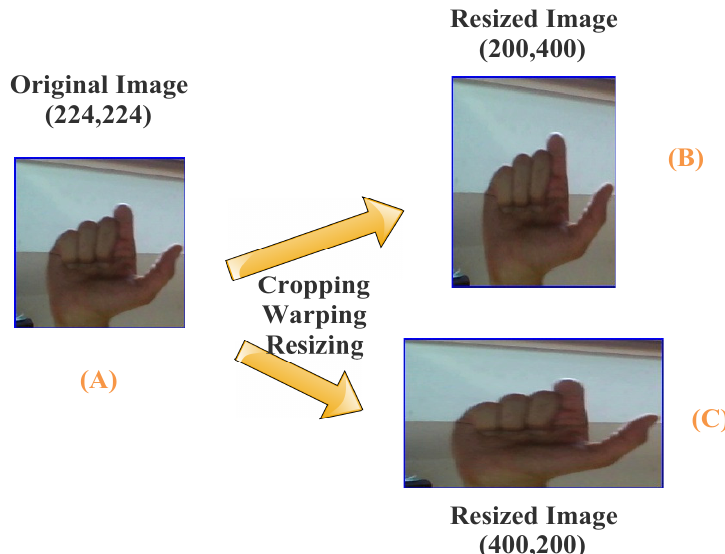
Figure 3. Image resizing cause distortion of spatial information, resulting mis-classification and restricting deep learning convolutional neural network (DCNN) input dimensions. Here, ( A ) is the original image, resizing it to feed into DCNN cause distortion shown in ( B , C